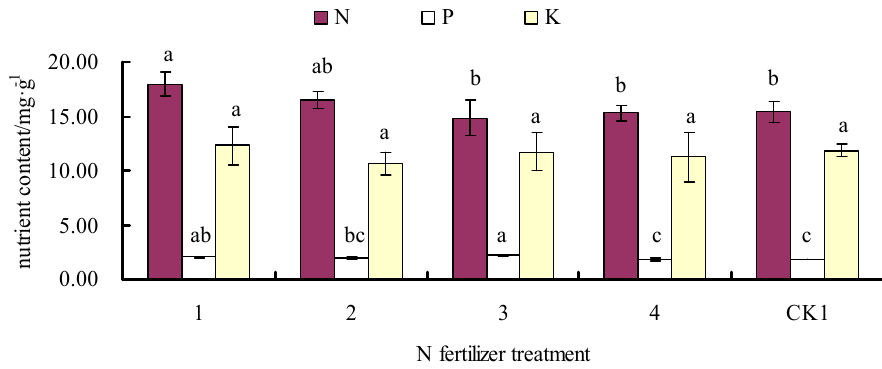
Figure 1. Effects of single N fertilizer application on G. biloba leaf N, P, and K contents in EXP.1.